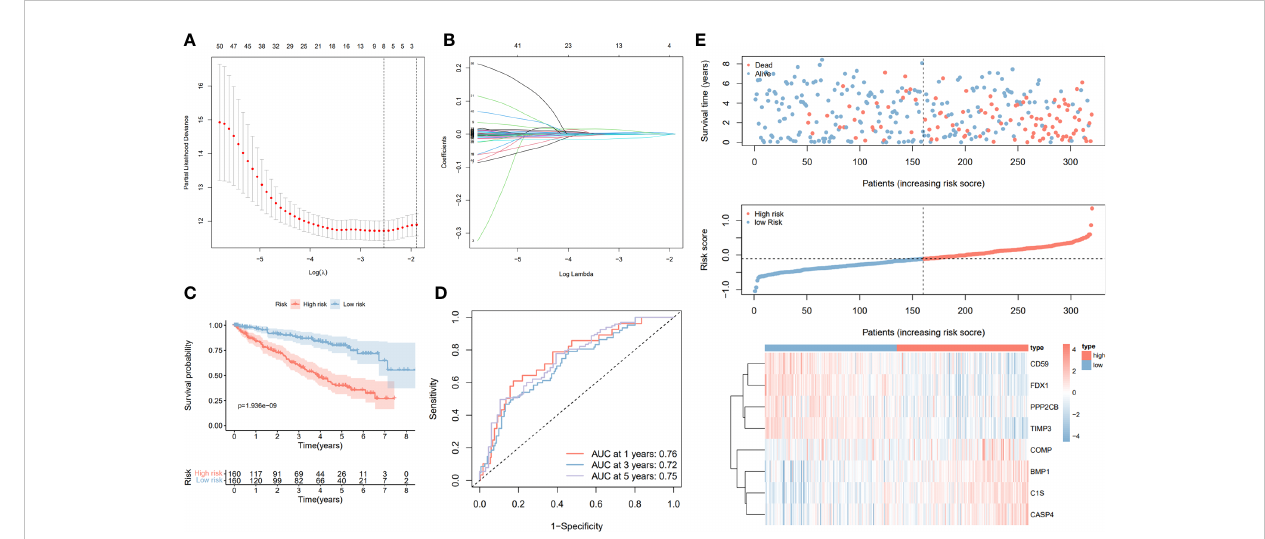
FIGURE 6 Construction and validation of the prognostic signature based on the CRGs. (A) Cross-validation of the parameter selection in the LASSO regression. (B) LASSO regression of the 8 CRGs related to the OS. (C) Kaplan – Meier survival curves between high- and low-risk groups. (D) The AUC value of ROC curves of prognostic signature for predicting 1-year, 3-year, and 5-year OS in the TCGA cohort. (E) Signature gene expression patterns and the distribution of survival status and risk score in the TCGA training